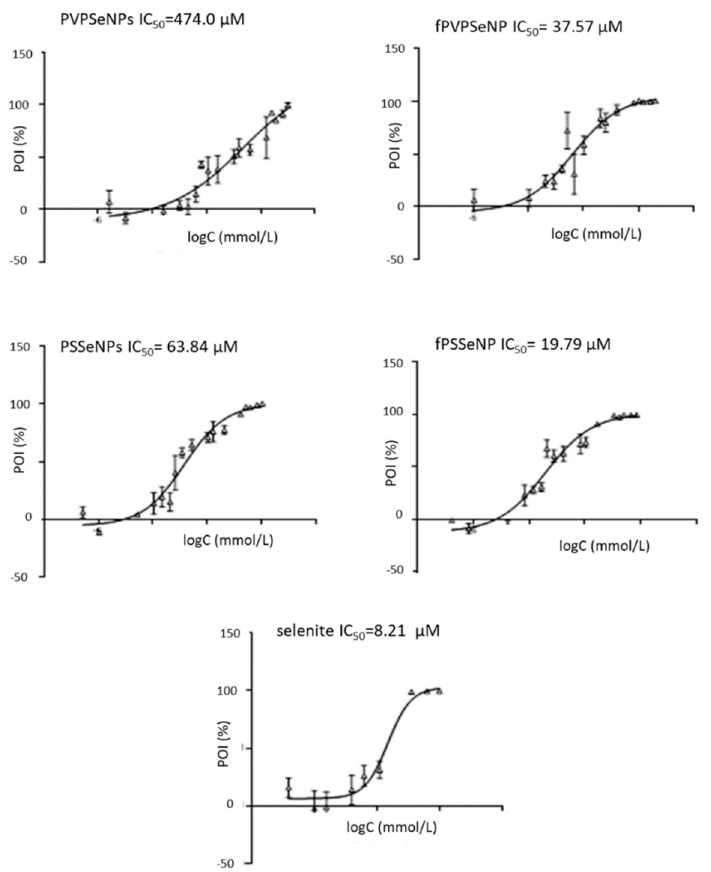
Figure 4. Cytotoxicity of different concentrations of selenium nanoparticles and sodium selenite in HepG2 cell lines. POI-percentage of inhibition; PVPSeNPs—selenium nanoparticles coated with